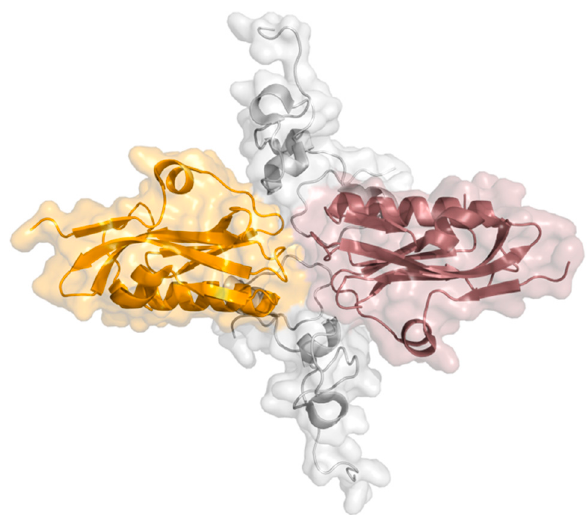
Figure 6. X-ray structure of NS1 effector domain bound to CPSF30 ′ s F2F3 finger (PDB ID: 2RHK) [87] (orange, NS1-ED monomer 1; pink, NS1-ED monomer 2; gray, CPSF30 ′ s F2F3 finger). NS1 inhibits double-stranded RNA-activated protein kinase (PKR), 2 ′ ,5 ′ -oligoadenylate